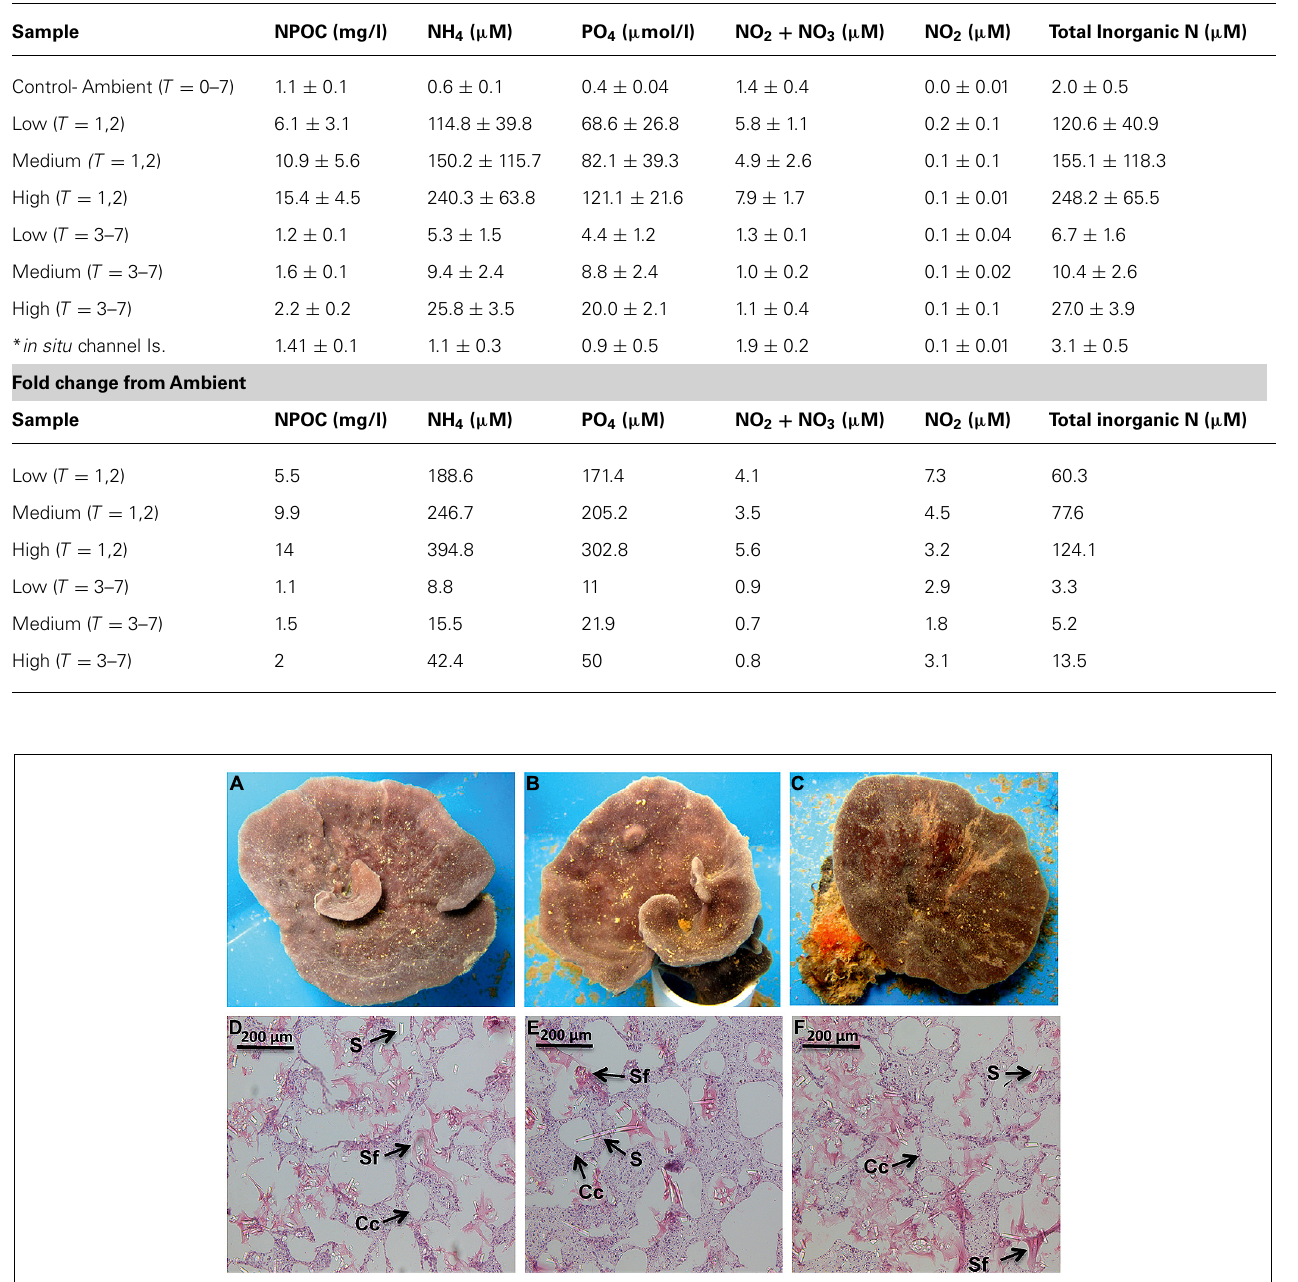
to treatment or time point ( Figure 6 ) and explained a lower amount of the total variation in the first two fac- tors (24.3%). The RNA-derived community shared only 20% similarity between all samples and was also not signifi- cantly different between nitrogen treatments (PERMNOVA, p =